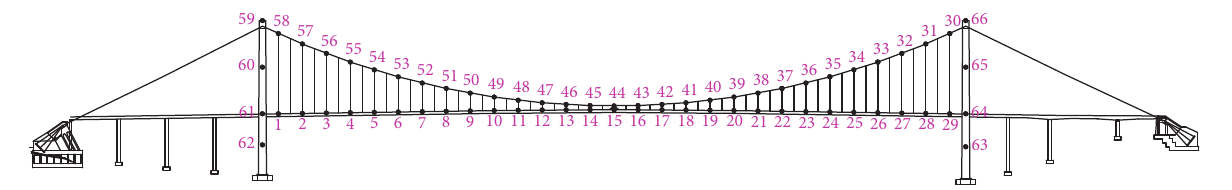
Figure 8: The layout of wind field simulation points on the